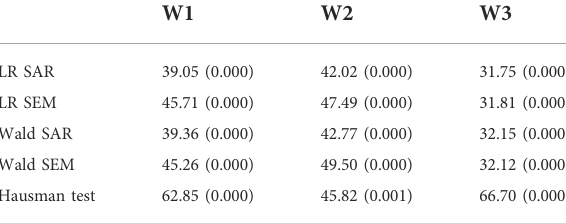
TABLE 4 Results of LR, Wald and Hausman